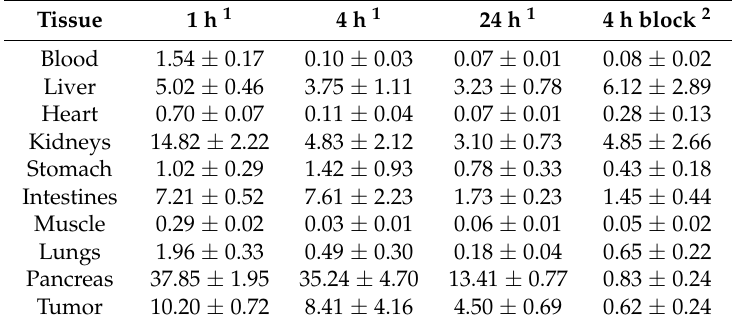
Table 2. Biodistribution data for 99m Tc-N 4 -GRP(14–27), expressed as %ID/g mean ± sd, n = 4, in PC-3 xenograft-bearing SCID mice at 1-h, 4-h block, 4-h, and 24-h